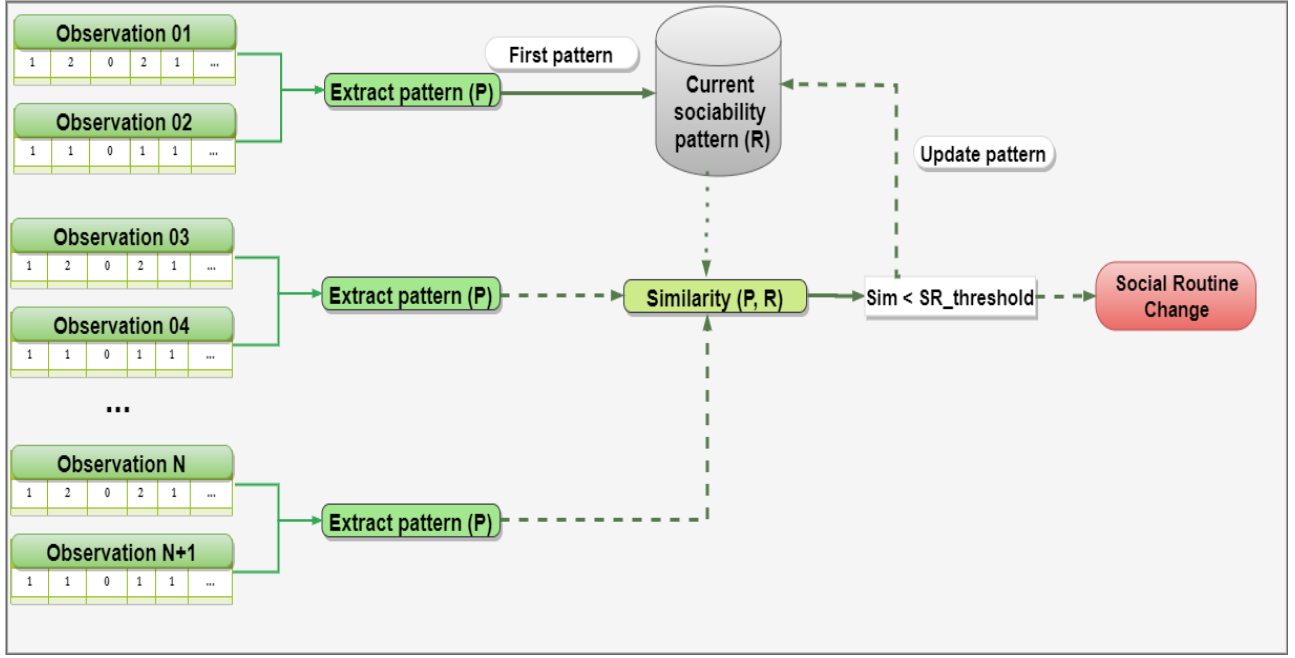
Figure 4. Strategy for detecting social routine